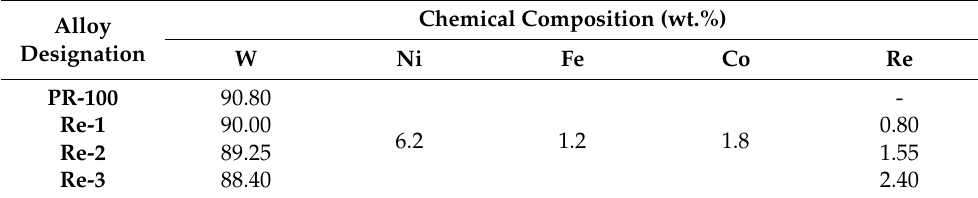
Table 1. Chemical composition of the alloys.